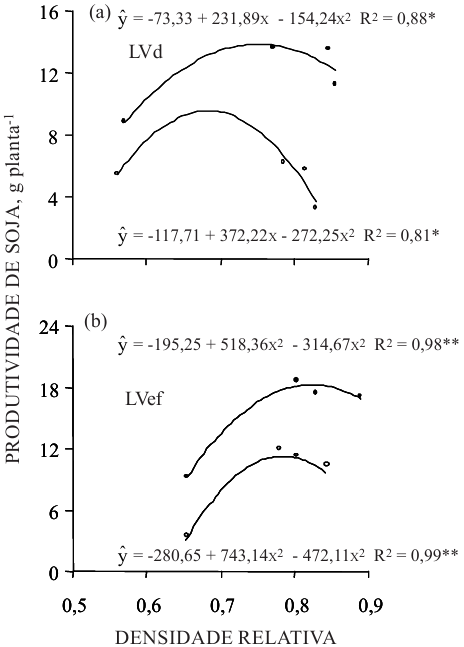
Figura 2. Regressão entre a densidade relativa do solo e a produtividade de grãos de soja, em casa de vegetação, no (a) Latossolo Vermelho de textura média (LVd) e (b) argiloso (LVef), na tensão de 0,01 (•) e 0,05 MPa ( ο ). **, * Significativos a 1 e 5 %, respectivamente.